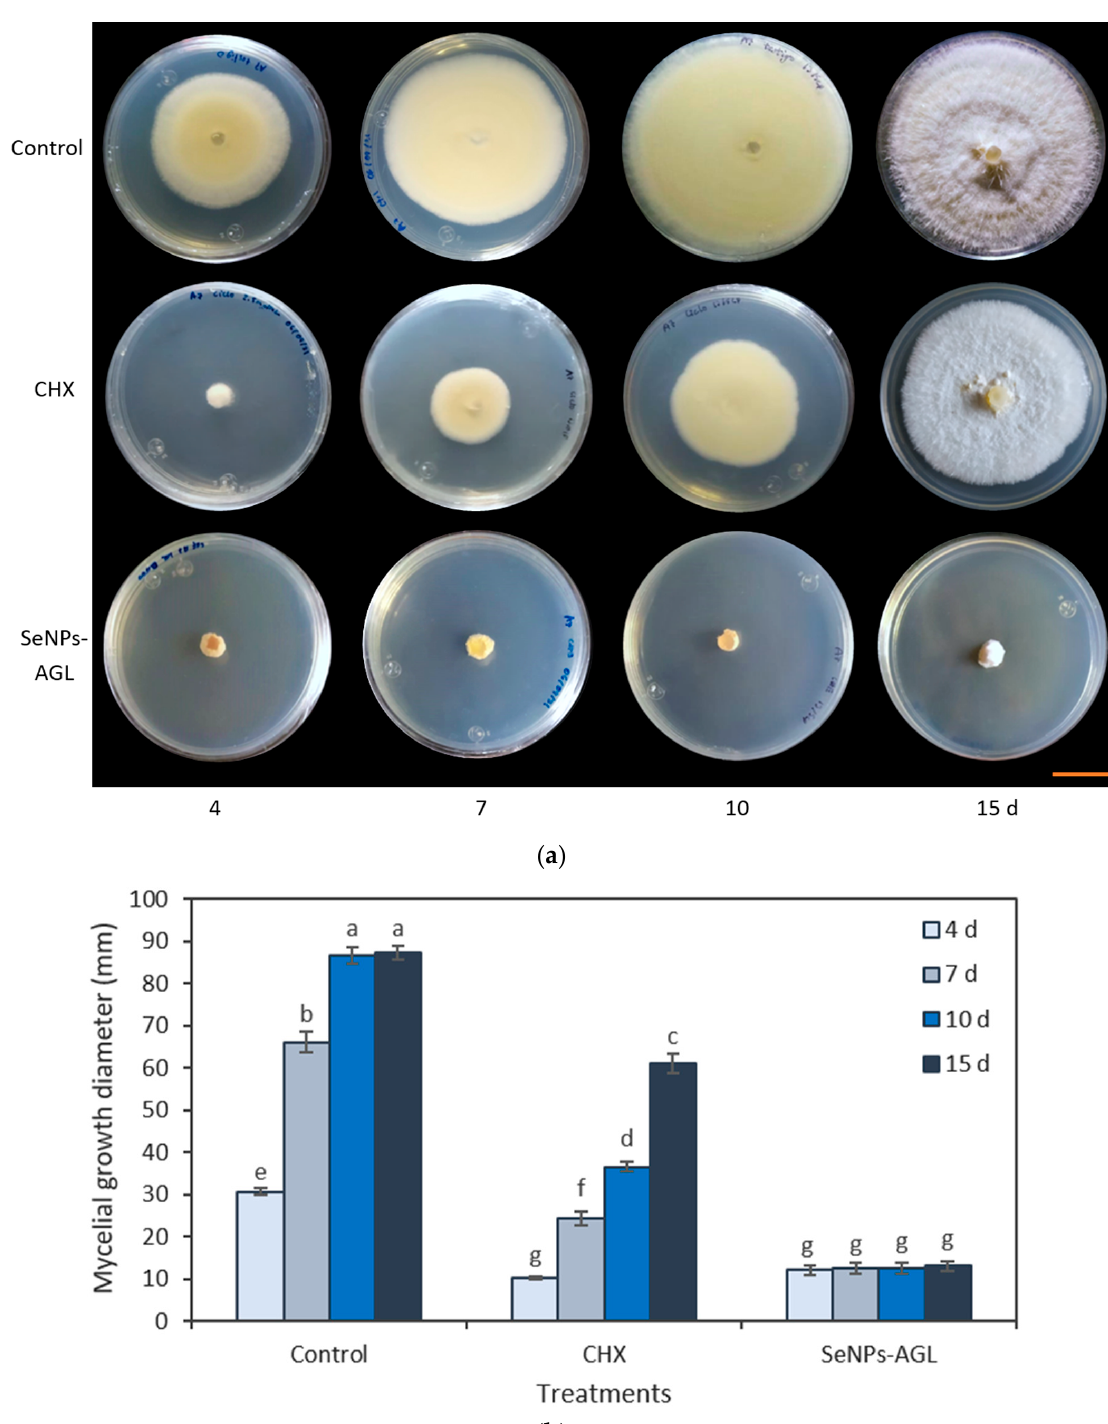
Figure 5. Antifungal activity of SeNPs synthesized with A. glaucum (AGL) extracts against C. gloeosporioides . ( a ) Representative photograph of the antifungal activity test under different treatments over time. SeNPs and CHX were applied at 1.7 mg/mL and 2.5 mg/mL, respectively. The scale bar is 2.5 cm. ( b ) Comparison of means of the effect of the SeNPs synthesized with extracts of A. glaucum against C. gloeosporioides . Mean values ± ee. Different letters indicate statistically significant differences according to Duncan’s test ( α = 0.05), p < 0.0001.